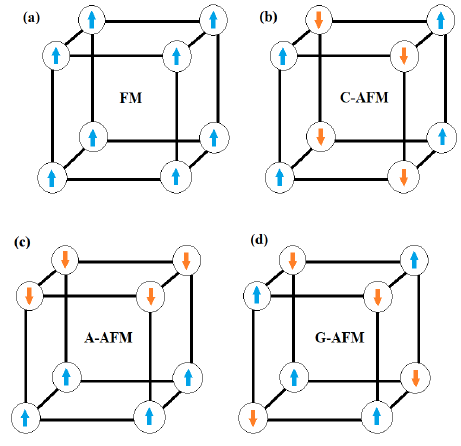
Figure 1. Schematic representation of ( a ) ferromagnetic (FM), ( b ) C-type anti-ferromagnetic (AFM), ( c ) A-type anti-ferromagnetic (C-AFM), and ( d ) G-type anti-ferromagnetic (G-AFM) spin arrange- ments for tetragonal